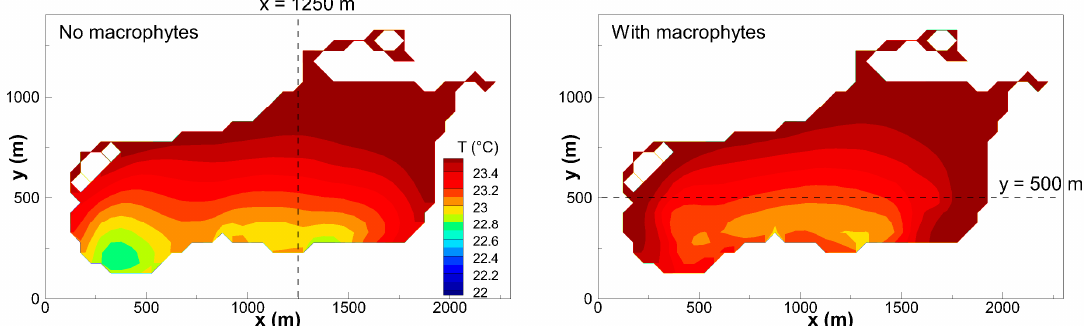
Figure 7. Modelled surface temperature fields without and with littoral macrophytes.